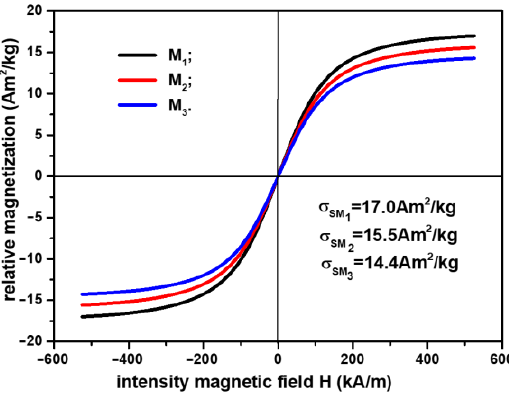
Figure 3. Magnetization slopes of membranes M 𝑖 (𝑖 = 1, 2, 3) .